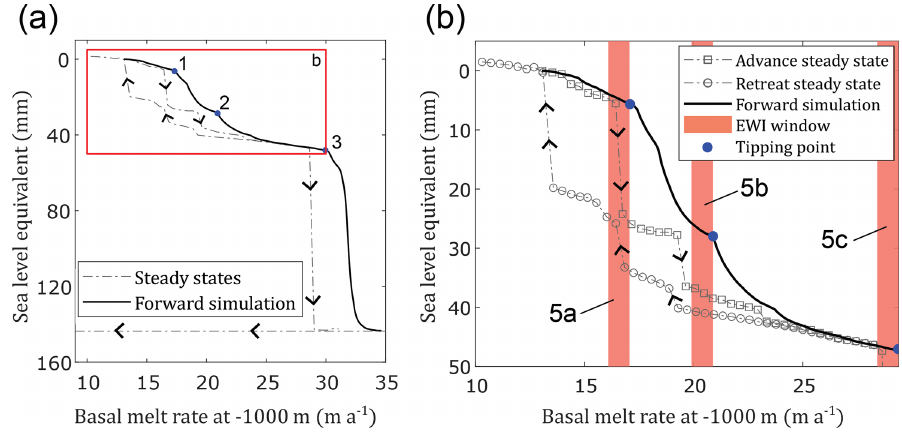
Figure 4. Change in system state in terms of sea-level equivalent ice volume as a function of the control parameter, which is the melt rate at the ice–ocean interface. (a) The model is run forward with a slowly increasing basal melt rate (solid black line) and shows three distinct tipping points (blue dots). From the start of the transient simulation to the third tipping point is approximately 10kyr. The steady states for a given melt rate in both an advance and retreat configuration are plotted as dashed grey lines, with details shown in panel (b) . Arrows indicate the direction of the hysteresis. Panel (b) focuses on the model response before the larger tipping point (event 3) and shows the three windows that we analyse for early warning indicators as shaded red boxes (Fig. 5). Circle and square symbols represent steady-state configurations for a given forcing, and the dashed grey line is a linear interpolation between these points. Each step in melt rate for the steady-state runs from ∼ 10 to ∼ 30ma − 1 is approximately equivalent to 0.4ma − 1 of basal melting, or 250 years in the transient simulation. The lower branch in panel (a) represents a simulation starting from the PIG configuration after the third major retreat event and reverses the basal melt rate factor to its lowest value, showing no recovery in ice